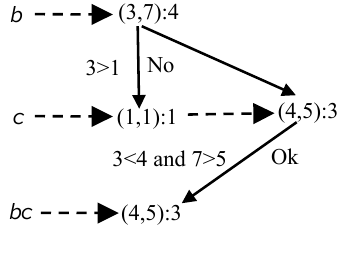
Fig.3. The Node-lists of bc in Example